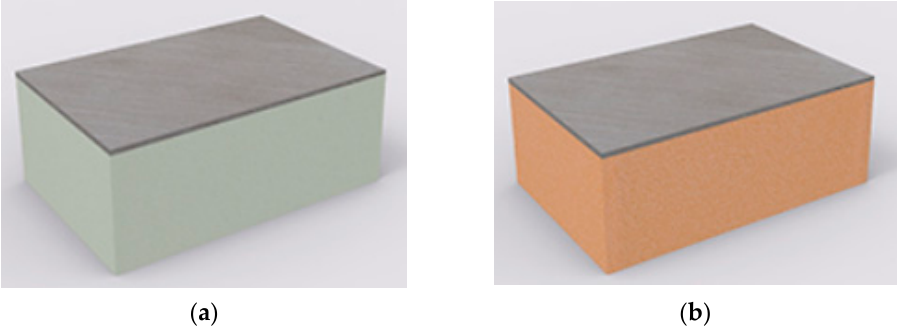
Figure 1. Foam blocks (Synbone, Zizers) with different density of: ( a ) 0.14 g/cm 3 ; ( b ) 0.35 g/cm 3 .